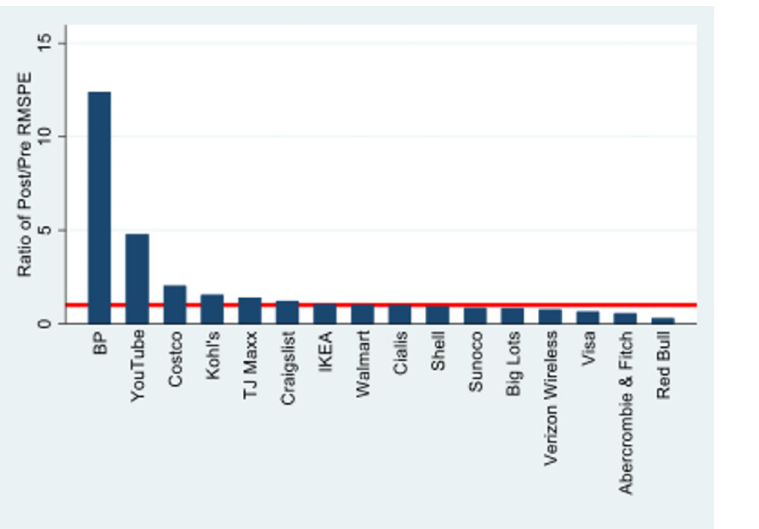
Fig 3. RMPSE ratios for BP and components of synthetic